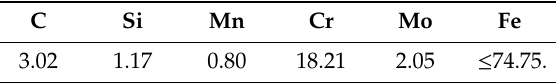
Table 1. Chemical composition (% in weight).